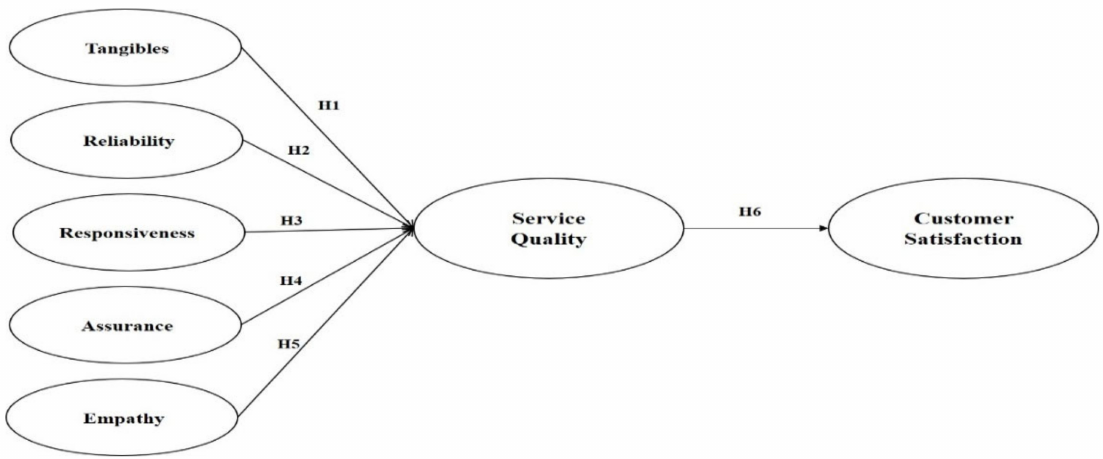
Figure 1. Theoretical